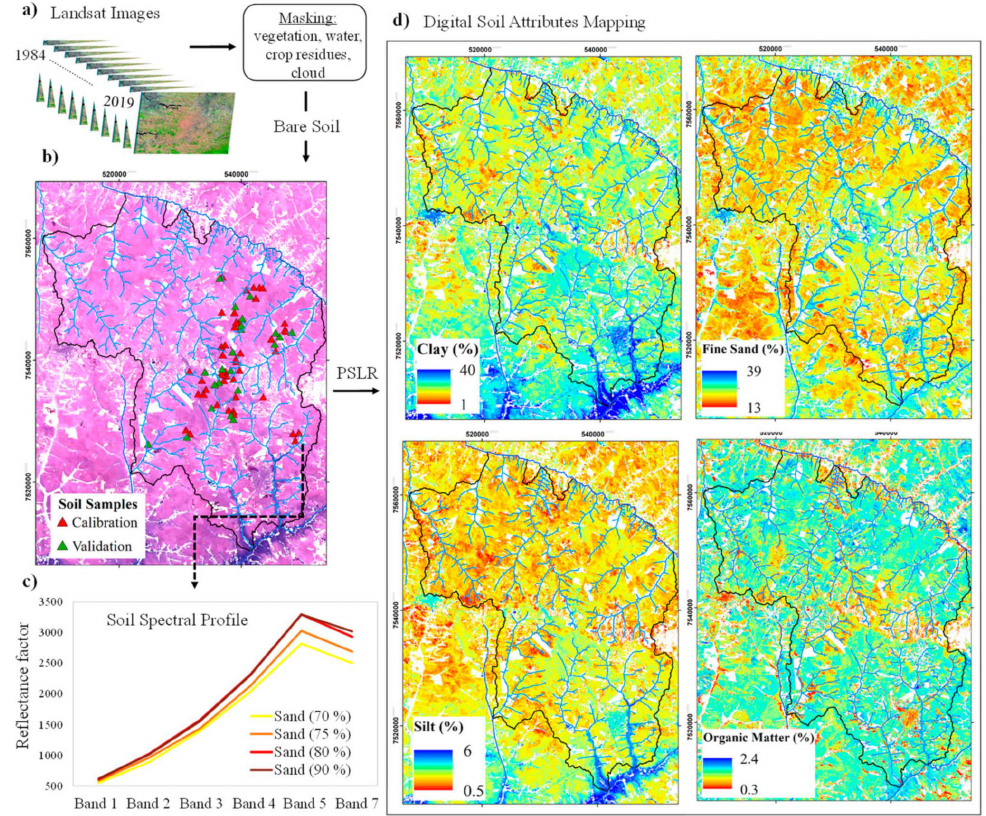
Figure 6. ( a ) Multi-temporal satellite images masks using NDVI and Mid-Infrared, ( b ) Soil Synthetic Image has shown the agricultural land in false color (RGB 543) of the Landsat data with the soil samples sites location used for the soil map attributes prediction by Partial Square Least Regression, ( c ) Soil spectral profile average from the soil samples, ( d ) Soil attributes map (clay, fine sand, silt, and organic matter) used to derive the erodibility factor map. Soil texture analyzes resulted in the following classes: Sand, Coarse Sand, Fine Sand, Silt and Clay. Note that only Clay, Fine Sand and Silt maps were generated to calculate erodibility, so the final percentage value will not be 100%. This would require all maps of all textural classes to reach